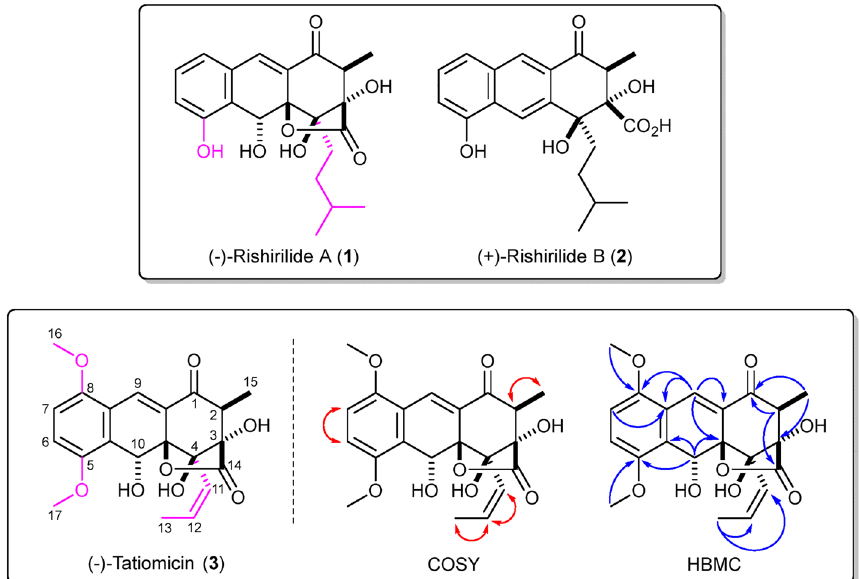
Figure 1. Top (–)-Rishirilide A ( 1 ) and ( +)-rishirilide B ( 2 ). Relative stereochemistry of (–)-1 and absolute stereochemistry of ( +)-2 shown. Bottom. Structure of (–)-tatiomicin ( 3 ) as derived from NMR and SCXRD experiments. Key COSY (red) and HMBC (blue) correlations shown. Absolute stereochemistry as shown by both vibrational circular dichroism (VCD) and single-crystal X-ray diffraction (SCXRD) resonant scattering experiments. Structural differences of rishirilide A and tatiomicin are highlighted